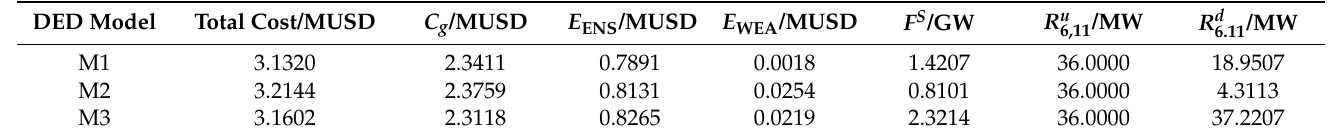
Table 1. Comparison of optimal dispatch solutions for each